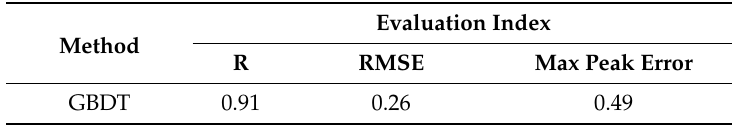
Table 22. Baseline evaluation indices when return-temperature setting of CRAC is 28 ◦ C (6 December 2019 to 10 December 2019; sample number: